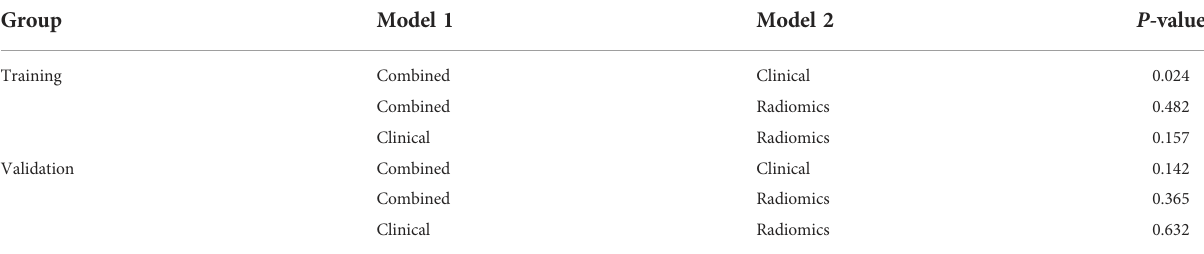
TABLE 4 Comparison of the prediction with the combined radiomics nomogram, clinical, and radiomics model.